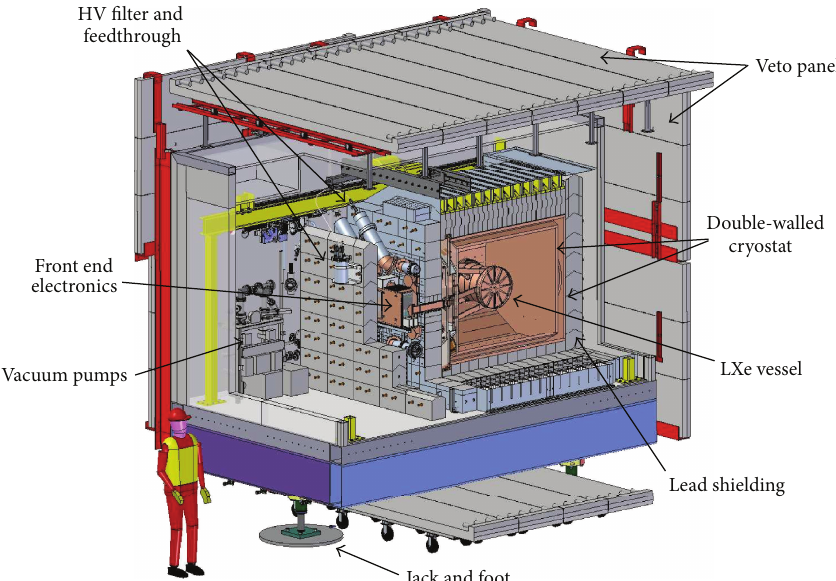
Figure 2: Overall detector configuration as installed at WIPP.